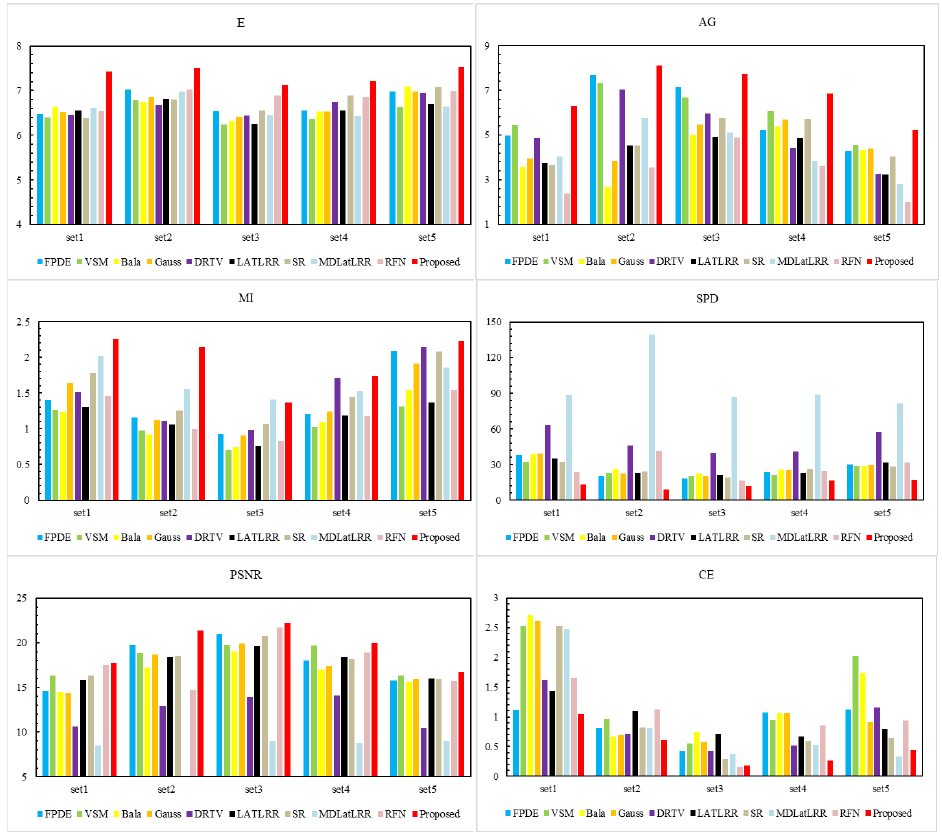
Figure 6. Comparison results of six evaluation parameters. The nine methods, i.e., FPDE, VSM, Bala, Gauss, DRTV, LATLRR, SR, MDLatLRR, RFN are compared with the proposed method.